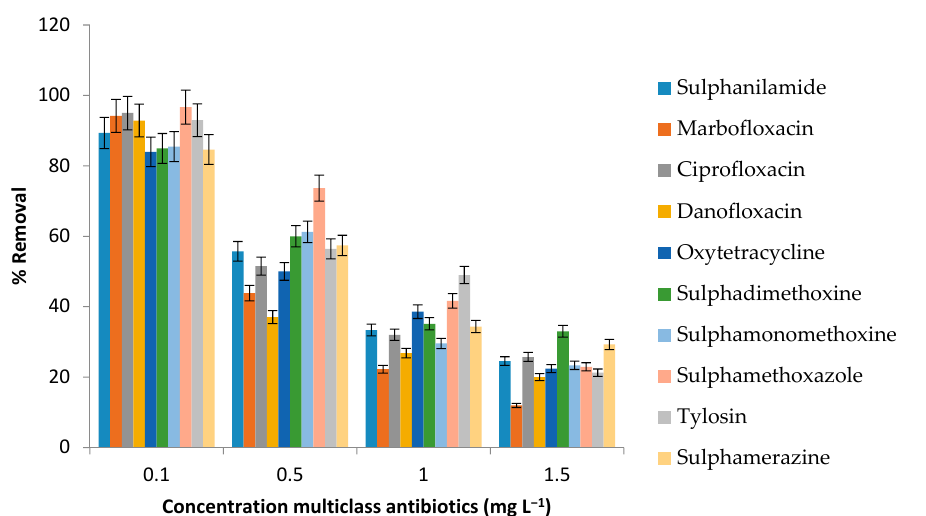
Figure 3. Effect of initial concentration on percentage removal of antibiotics using water-solubleprotein powder (n = 5).